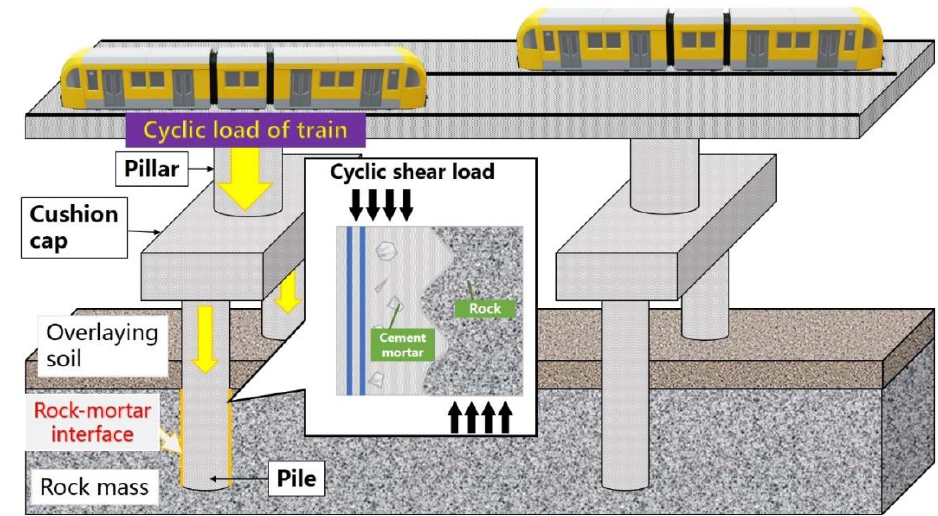
Figure 2. Interface between rock-socketed pile and bedrock in high-speed railway.